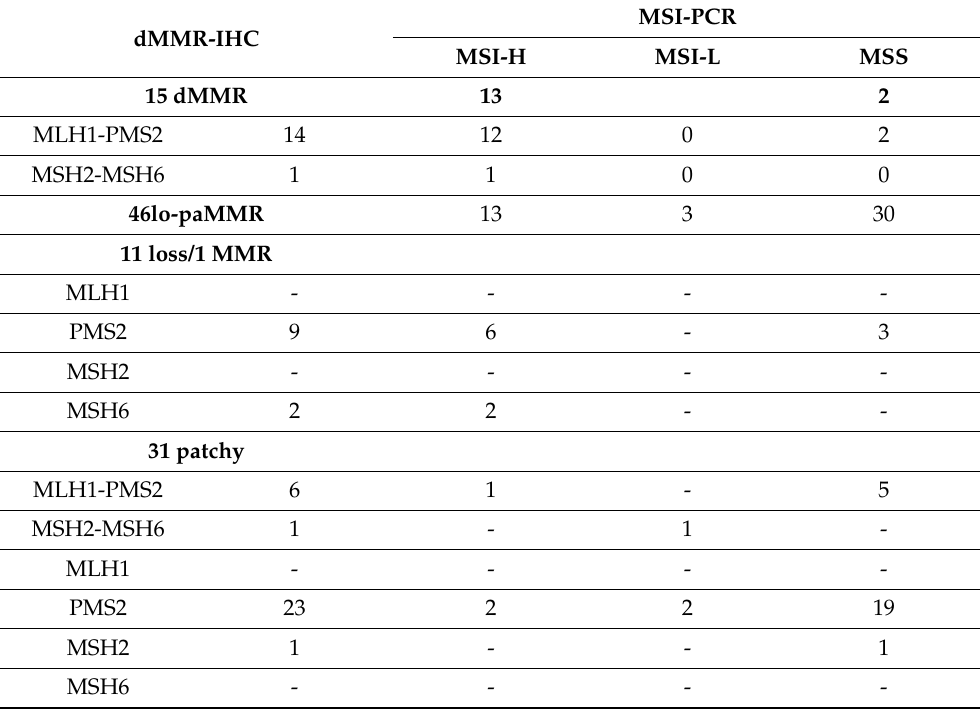
Figure 5. Representative results of CRC case showing paMMR-IHC and MSI-H by PCR. ( A ) MMR- IHC results: intact expression of MLH1, MSH2 and MSH6 in tumor cells (original magnification 10 × ); patchy expression of PMS2 in tumor cells with positive internal control (original magnification 10 × ). ( B ) MSI-PCR results: stability of BAT25 and NR22; instability of BAT26, NR21, NR24, NR27, CAT25 and MONO27 (red lines indicate samples while blue lines indicate MSS controls). Table 2. Comparison between MMR-IHC and RT-PCR results in our CRCs